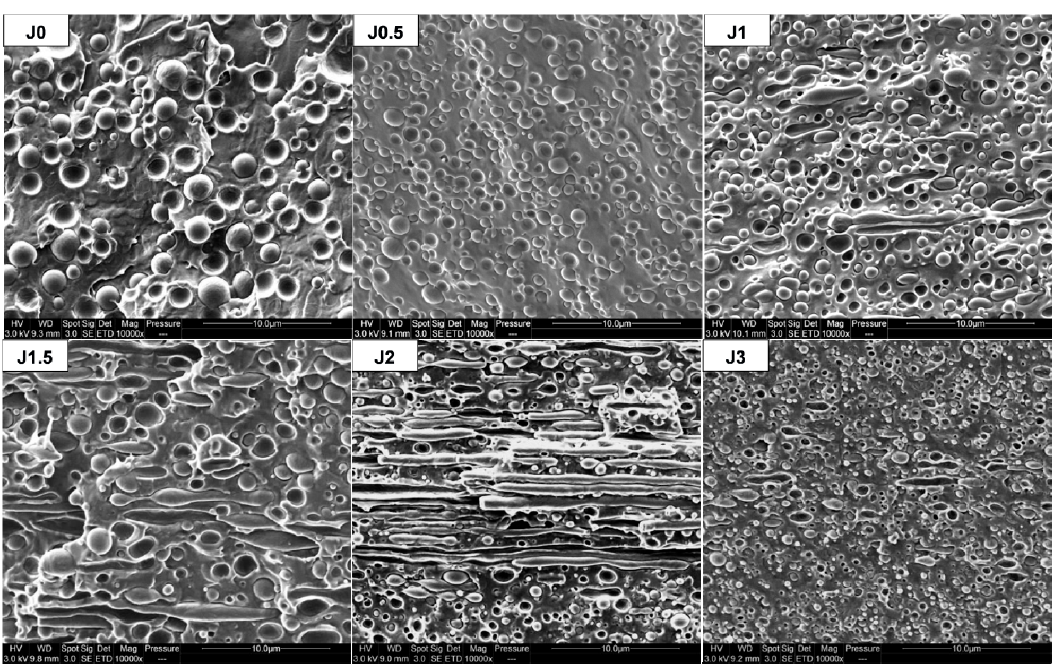
Figure 6. SEM observations of FDM filaments in longitudinal direction.